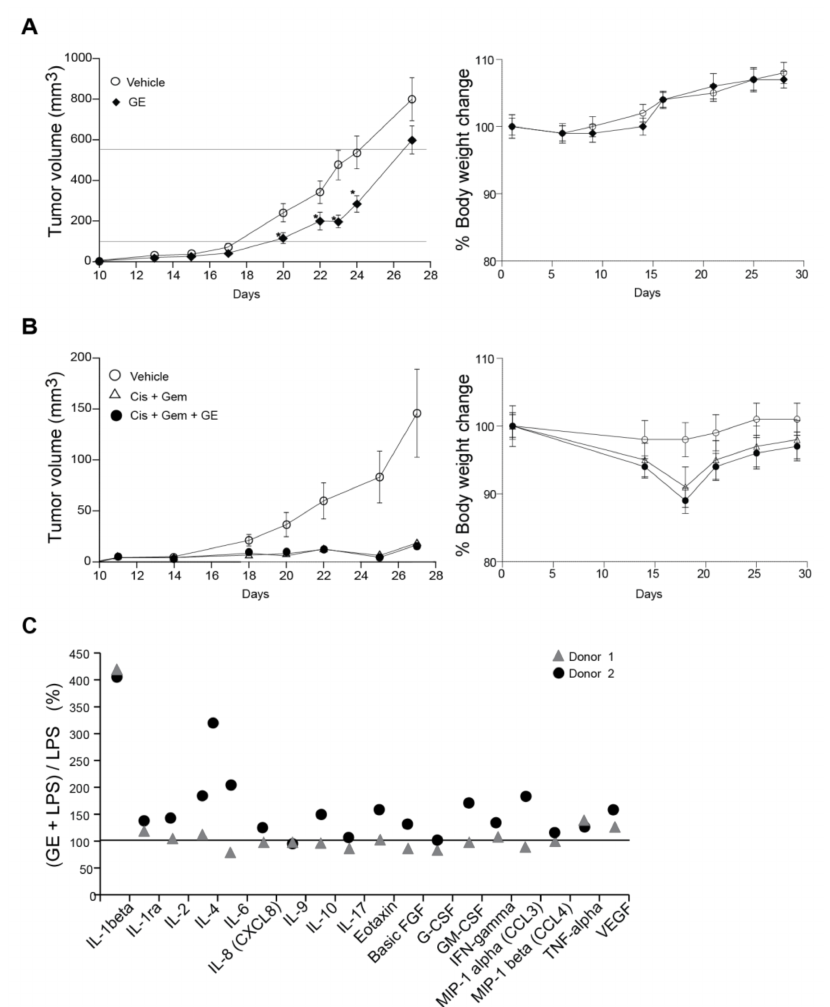
Figure 4. GE reduces breast cancer growth in vivo and partly influences the cytokine response from lipopolysaccharide (LPS)-stimulated monocytes. ( A , B ) 67NR breast cancer cells were injected into the fourth mammary fat pad of female BalB-C mice. ( A ) The mice were treated with vehicle (6.5 µ L 20% ethanol in 200 µ L NaCl, n = 16) and GE (6.5 µ L in 200 µ L NaCl, n = 16) intraperitoneally (i.p.) once every day from day one (two-tailed, unpaired, t -test, * p < 0.05). ( B ) The mice that were treated with vehicle (6.5 µ L 20% ethanol in 200 µ L NaCl, n = 16), Gem + Cis (gemcitabine (0.5 mg/kg) + cisplatin (3 mg/kg), i.p., 200 µ L, n = 15, given once per week for three weeks, starting at day eight), alone and in combination with GE (6.5 µ L in 200 µ L NaCl, n = 16, i.p., once every day from day one). Mean ± SEM are shown. ( C ) The % increased levels of cytokines released by monocytes stimulated with GE (1:1000) + LPS (10 ng/mL), relative to monocytes stimulated by LPS only (horizontal line). Only cytokines that had >2 folds induction by addition of LPS are